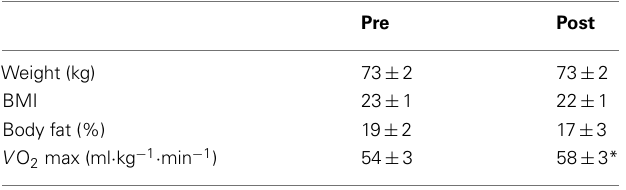
Table 1 | Subject characteristics at baseline and after 8weeks of rhEpo treatment.